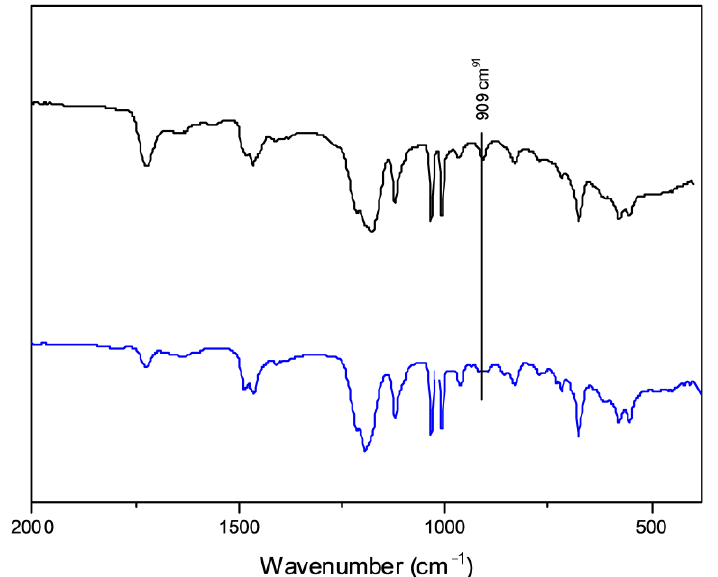
Figure 3. ATR-FTIR spectra of the film P(SSAmC 16 60-co-VBCHAM20-co-GMA20)/PAA before line) and after (blue line) cross-linking at 120 ◦ (black line) and after (blue line) cross-linking at 120 °C.